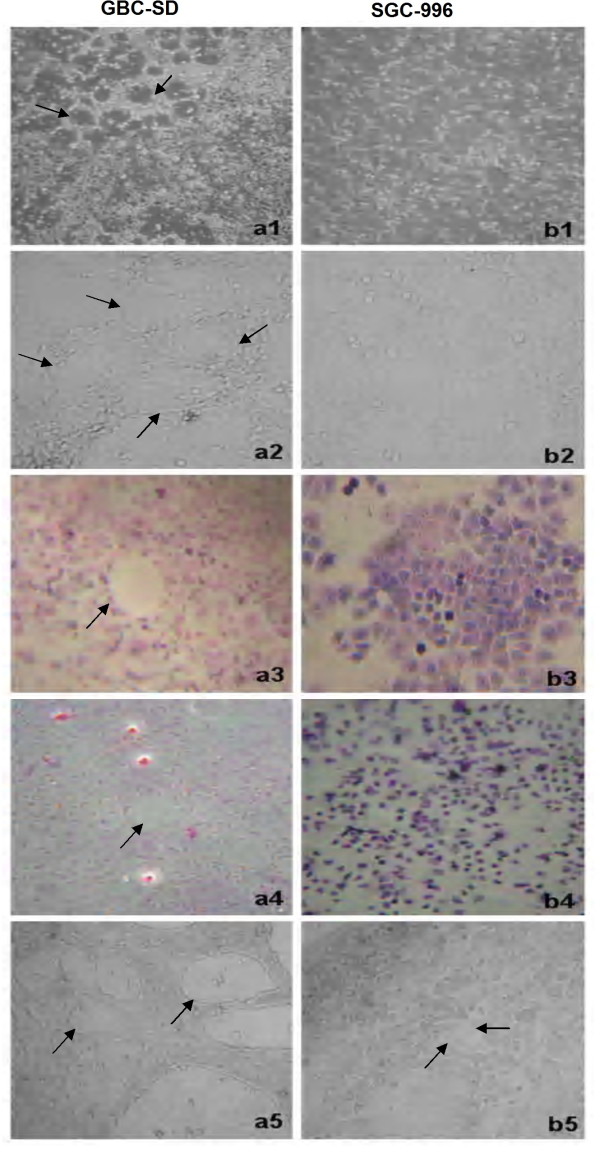
Phase contrast microscopy of human gallbladder carcinoma cell lines GBC-SD (a) and SGC-996 (b) cultured three-dimensionally on Matrigel (a1, b1; original magnification × 100) and rat-tail collagenⅠmatrix (a2-5, b2-5, original magnification × 200) in vitro. Highly aggressive GBC-SD cells form patterned, vasculogenic-like networks when being cultured on Matrigel (a1) and rat-tail collagenⅠmatrix (a2) for 14 days. Similarly, the three-dimensional cultures of GBC-SD cells stained with H&E showed the vasculogenic-like structure at three weeks (a3); PAS positive, cherry-red materials found in granules and patches in the cytoplasm of GBC-SD cells appeared around the signal cell or cell clusters when stained with PAS without hematoxylin counterstain (a4). However, poorly aggressive SGC-996 cells did not form these networks when cultured under the same conditions (b1-4). GBC-SD cells cultured on a SGC-996 cells preconditioned matrix were not inhibited in the formation of the patterned networks by the poorly aggressive cell preconditioned matrix (a5). Poorly aggressive SGC-996 cells form pattern, vasculogenic-like networks when being cultured on a matrix preconditioned by the GBC-SD cells (b5).